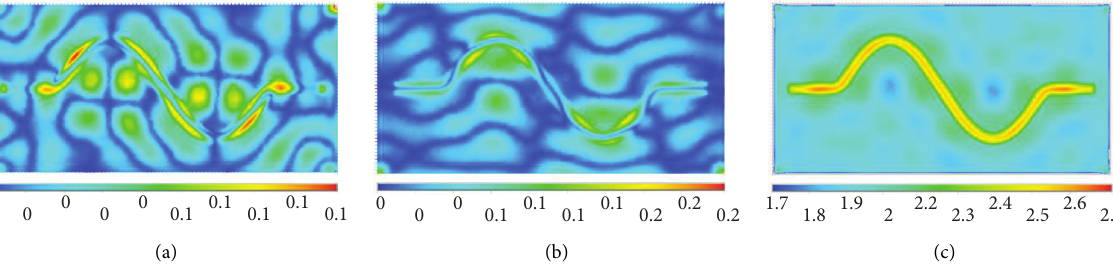
Figure 10: P wave incident ( f � 1.5Hz, H � 100m, C